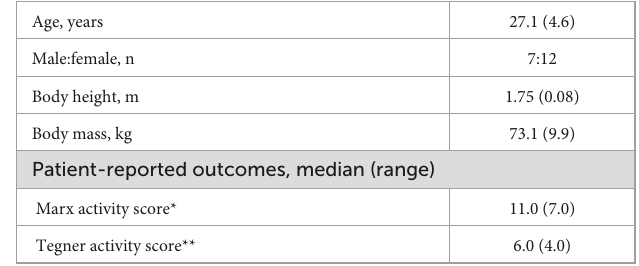
TABLE 1 Participant characteristics of the study group ( n = 19).